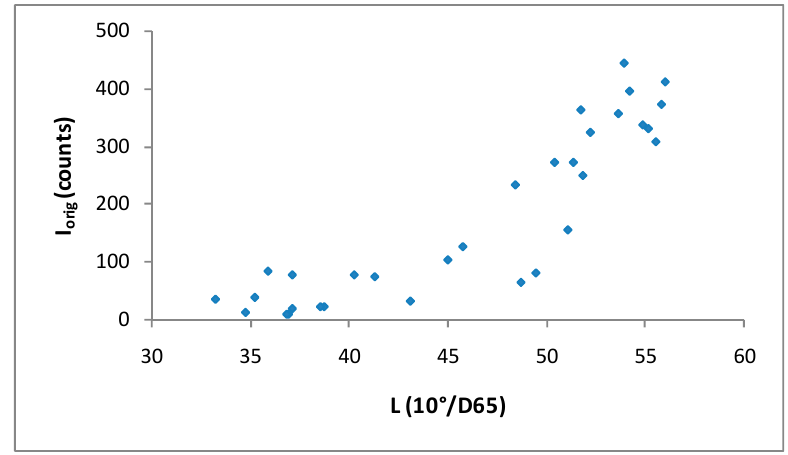
Figure 4. Relationship between the XRD intensity of the main (104) calcite peak (I orig ) and the sediment lightness (L*).